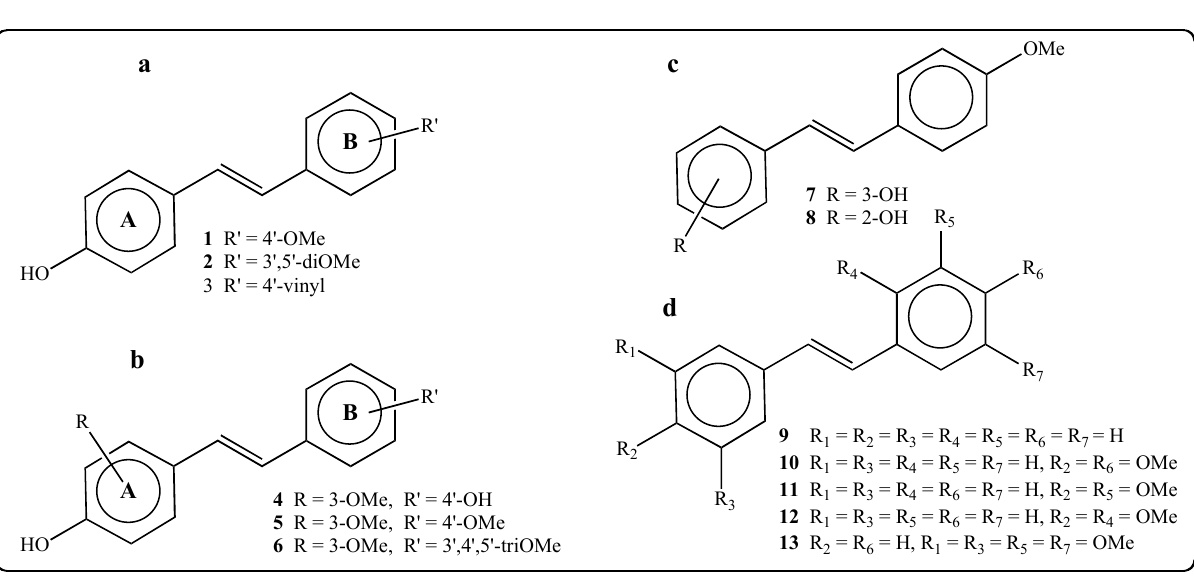
Figure 1. Structure of the stilbenes used for bioassays. ( a ) 4-OH stilbenes bearing substituents on cycle B; ( b ) 4-OH stilbenes bearing substituents on cycle A and/or cycle B; ( c ) Structure of 2-OH and 3-OH stilbenes; ( d ) Structure of stilbenes without phenolic